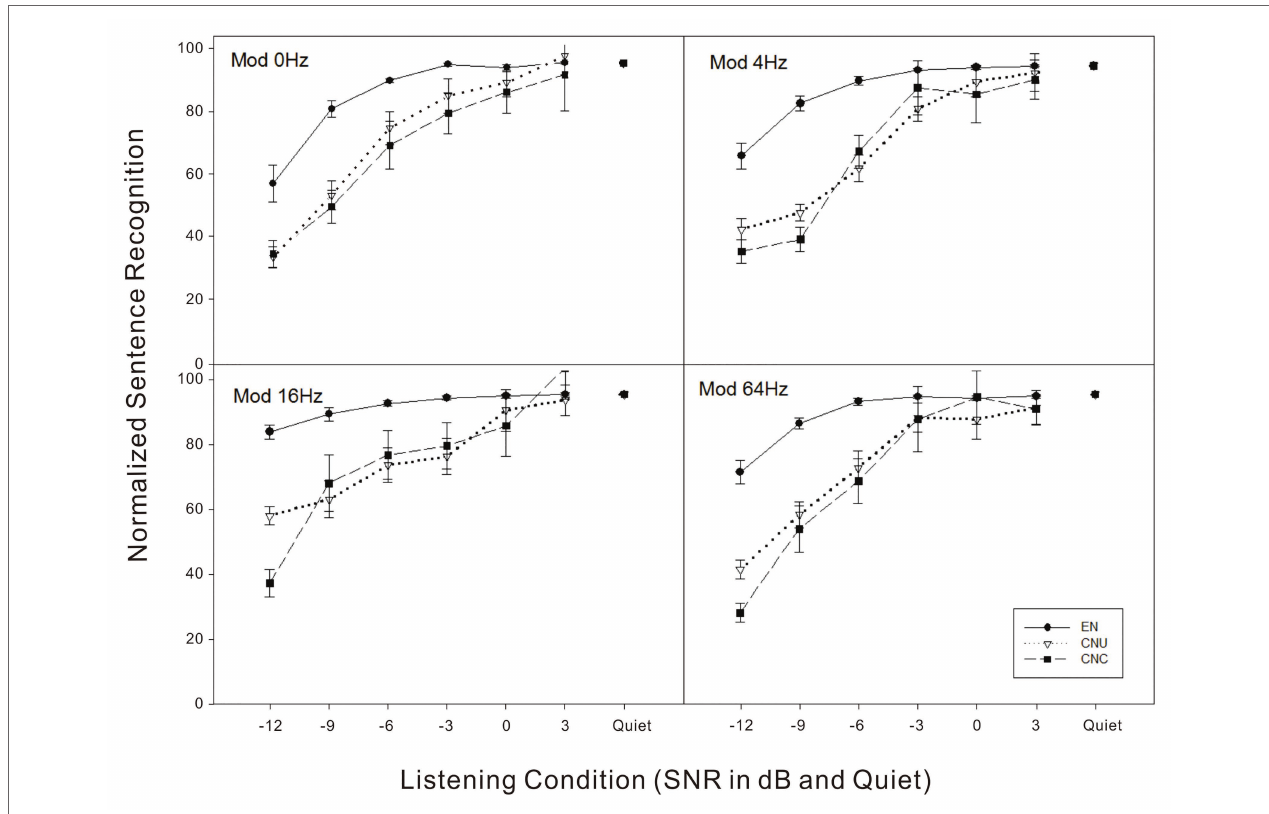
FIGURE 3 | Normalized sentence recognition scores (e.g., recognition scores in noise/quiet divided by scores in quiet) as a function of listening condition (quiet and signal-to-noise ratio in dB) for four noise conditions (top left – Mod 0 Hz: stationary noise; top right – Mod 4 Hz: noise temporally modulated at 4 Hz; bottom left – Mod 16 Hz: noise temporally modulated at 16 Hz; and bottom right – Mod 64 Hz: noise temporally modulated at 64 Hz) for three groups of listeners: EN listeners, CNU, and